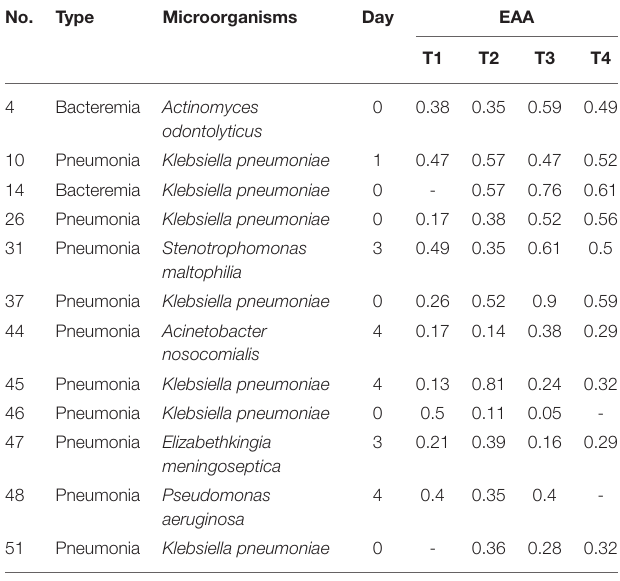
TABLE 6 | EAA levels in VA-ECMO patients with a proven infection within